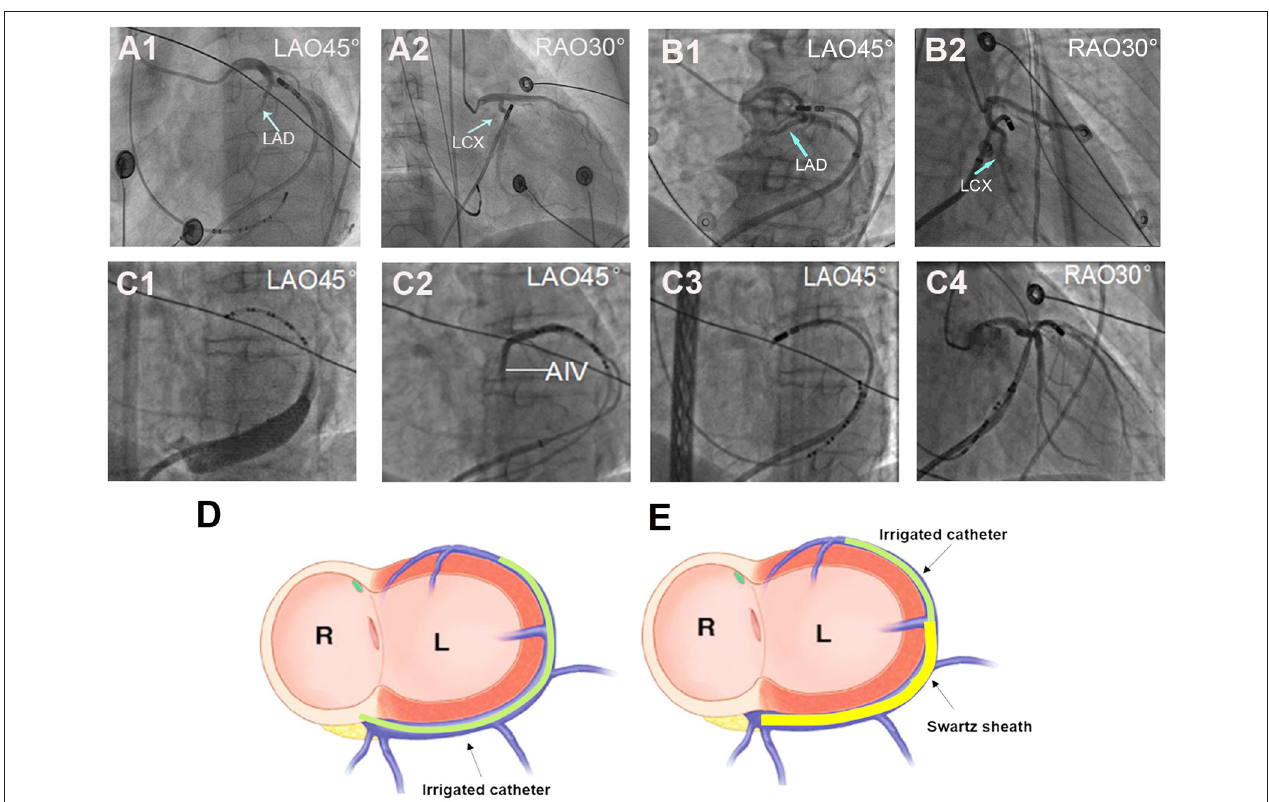
FIGURE 1 | Different approaches for ablation catheter reaching target sites in DGCV. (A) Manipulation of the ablation catheter in GCV by non-Swartz sheath support (NS) approach. (A1,A2) The tip of the catheter was delivered to DGCV from the ostium of the coronary sinus directly. (B) Manipulation of the ablation catheter in GCV by Swartz sheath support (SS) approach. (B1,B2) The tip of the catheter was delivered to summit-CV with support from Swartz sheath in the GCV. (C) Super smooth guidewire and left coronary angiographic catheter-guided deep engagement of Swartz sheath in GCV. (C1) Due to the blockage of the Vieussens valve (shown by coronary venography), even with the support of Swartz sheath, the catheter tip could not reach the middle part of GCV. (C2) The hydrophilic coated guide wire and Judkin’s 4-left coronary catheter were delivered through a Swartz sheath and passed the Vieussens valve and reached the DGCV. (C3,C4) The guided guide wire and coronary catheter, the Swartz sheath was advanced alternately and passed the Vieussens valve, then the guidewire and Jukin’s catheter was exchanged with ablation catheter to perform mapping and ablation in DGCV. (D) Schema of NS approach for DGCV-AIV VAs. Targeting DGCV-AIV VAs via advancing ablation catheter from the ostium of coronary sinus directly. (E) Schema of SS approach for DGCV-AIV VAs. Targeting DGCV-AIV VAs via advancing ablation catheter from the ostium of the coronary sinus with the support from Swartz sheath. LAD, left anterior descending artery; LCX, left circumflex artery. LAO, left anterior oblique; RAO, right anterior